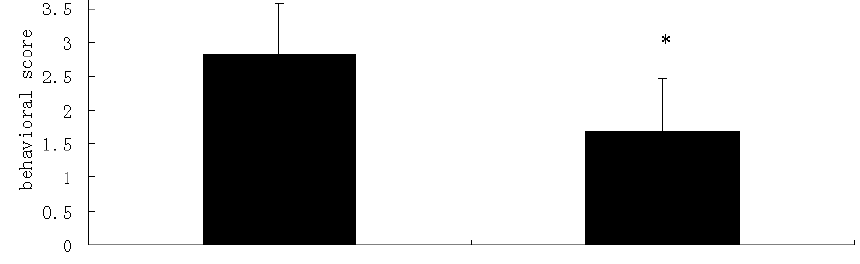
Figure 3. Behavioral scores of the exercise group and the non-exercise group. Data are mean ± S.D. (n = 6). The behavioral evaluation scores for the sham group were all zero. * indicates a statistically signi fi cant difference observed in the mean behavioral scores between the exercise group and the non-exercise group (P <